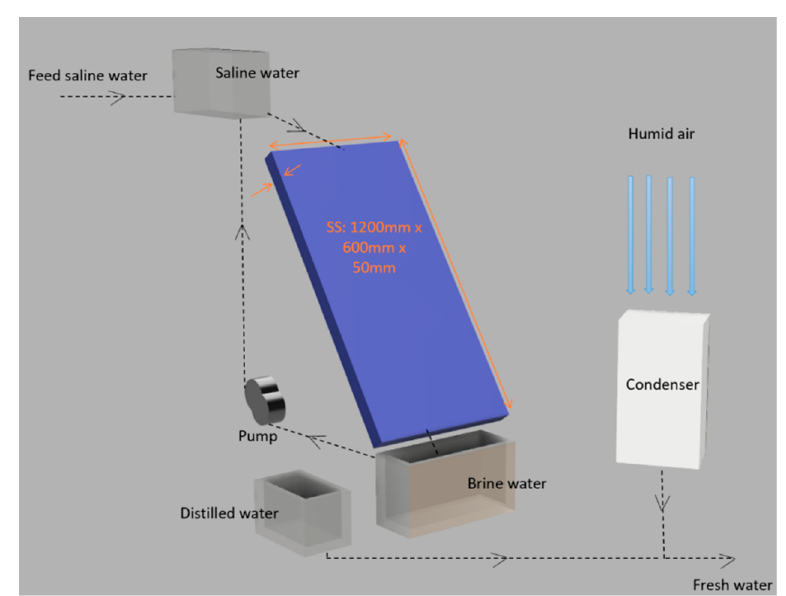
Figure 2. Water flow from the saline water barrel to the solar stills (SS) added to the condenser.